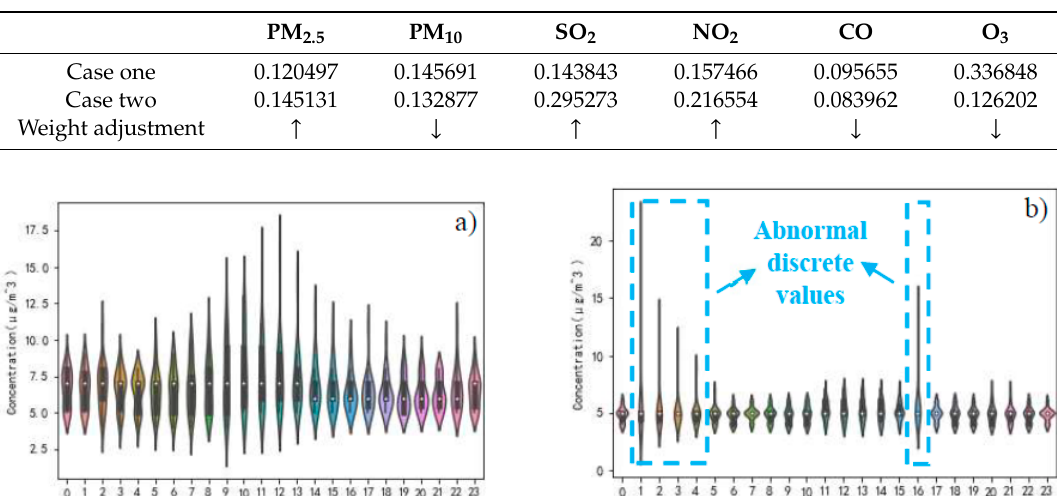
Table 4. Comparison of entropy weights of six pollutants.